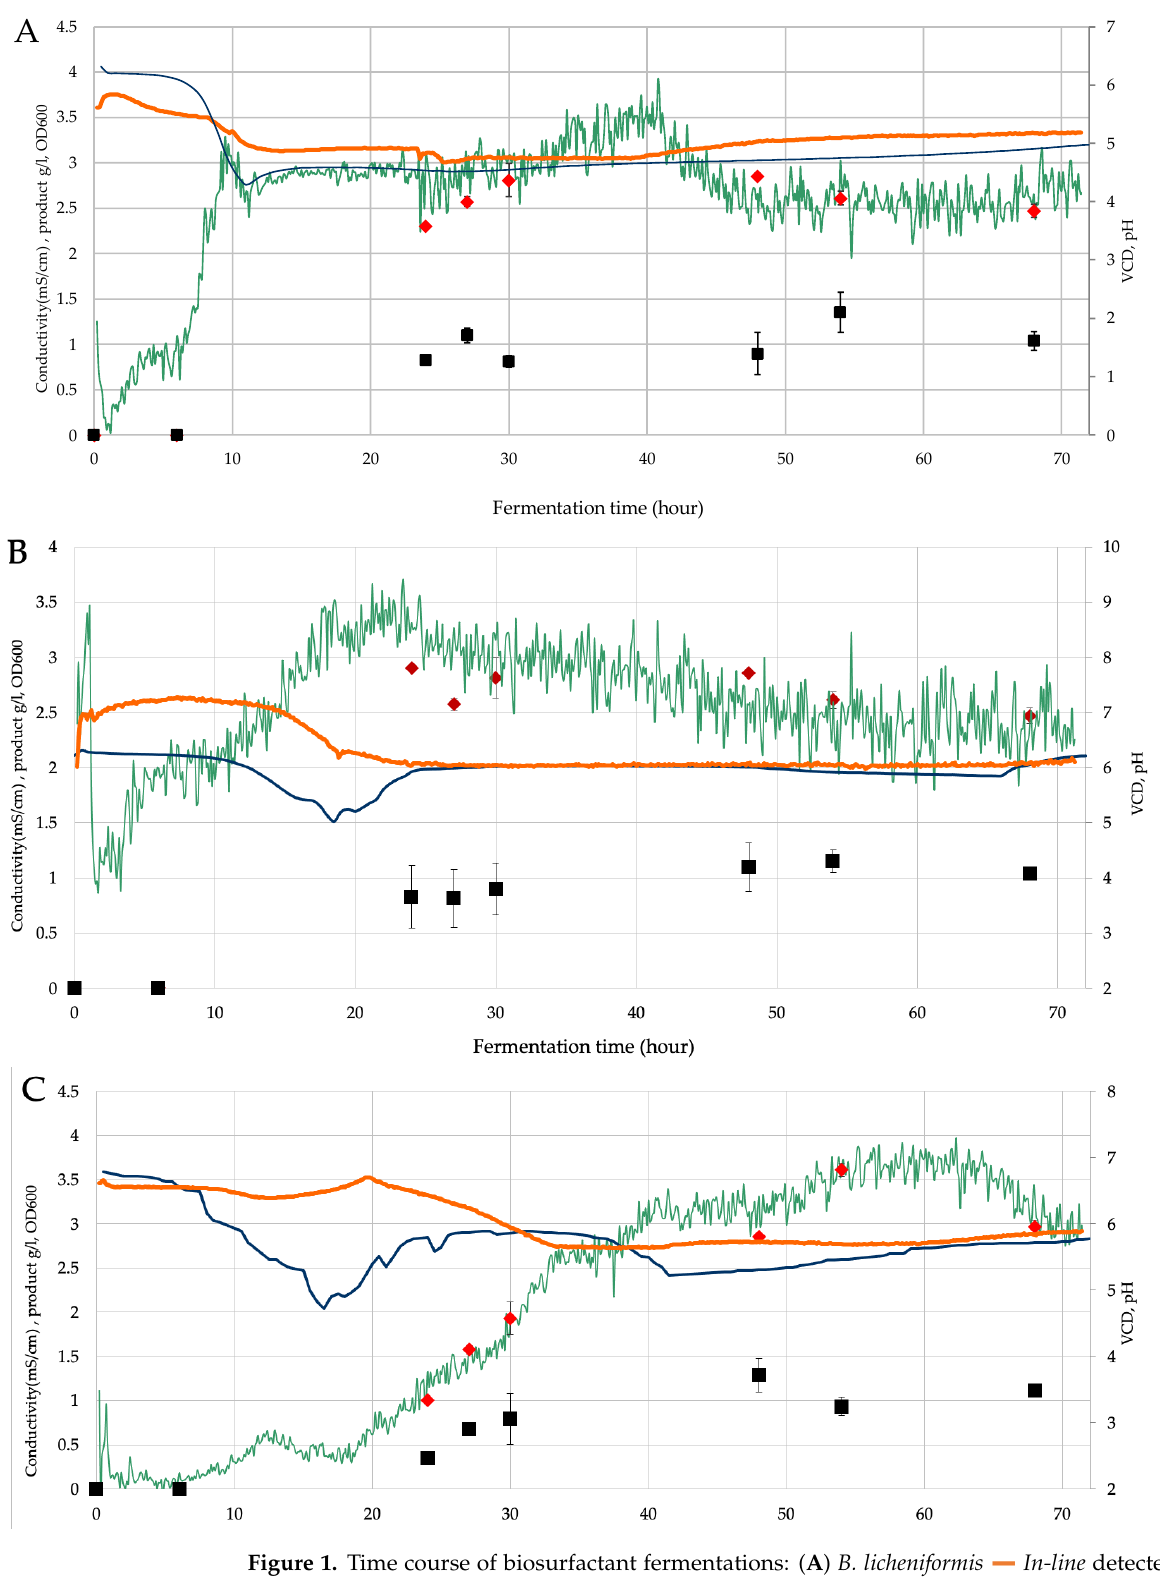
Figure 1. Time course of biosurfactant fermentations: ( A ) B. licheniformis ▬ In-line detected total products IDTP (=0.65 × conductivity [mS/cm] + 0.1); ( B ) B. subtilis ▬ IDTP (=0.65× conductivity [mS/cm] + 0.1); ( C ) G. stearothermophilus ▬ IDTP (=0.65* conductivity [mS/cm] + 0.1) biosurfactant fermentation, ▬ pH, ▬ VCD (=10× permittivity [mS/cm] + 1.8), ◊ OD600 and ■ product.